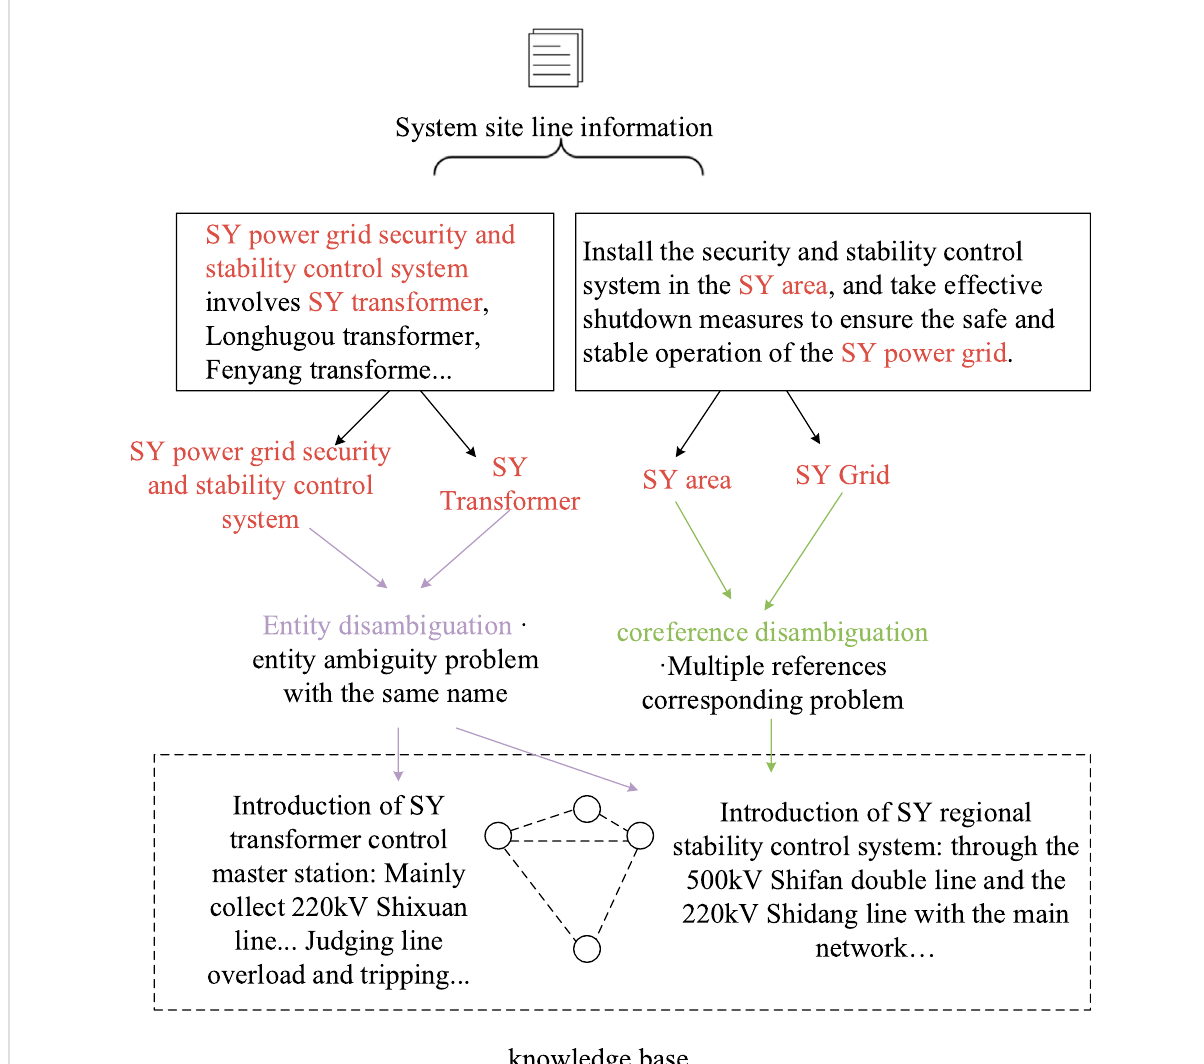
FIGURE 9 Entity link